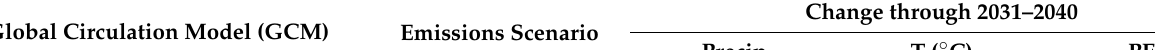
Table 4. Selected climate scenarios. With column one indicating the specific model run as quoted in Cervigni et al. [10]. The second column indicates the Representative Concentration Pathway (RCP) emissions scenario to which the model run corresponds. While the remaining columns indicate precipitation, temperature and potential evapotranspiration (PET)